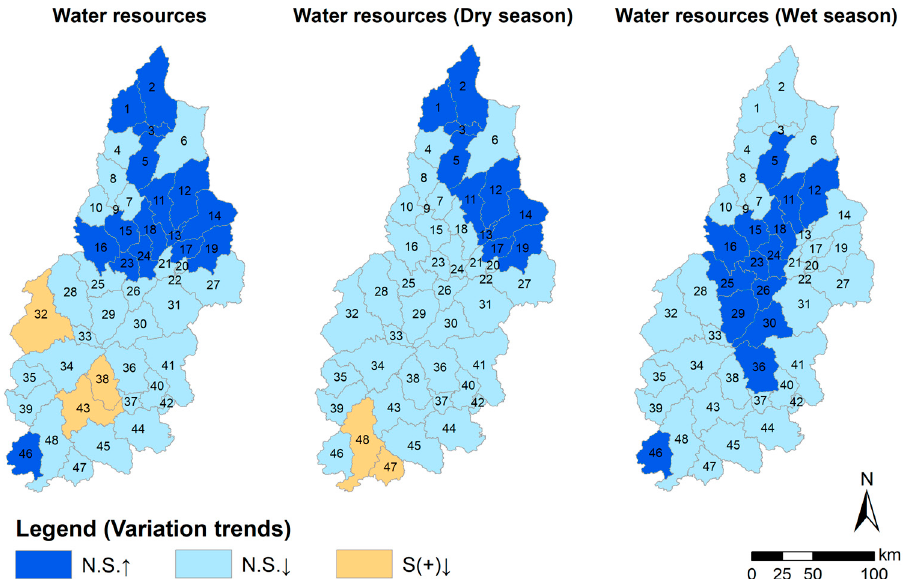
Figure 3. Spatial distribution pattern of variation trend of water resources (10 8 m 3 ) (billion cubic meters) in subbasins from 1970 to 2020. Note a: S indicates significant M-K test; N.S. indicates not significant. ↑ Indicates an increase; ↓ indicates a decrease. Note b: + indicates significant at the α = 0.1 level.